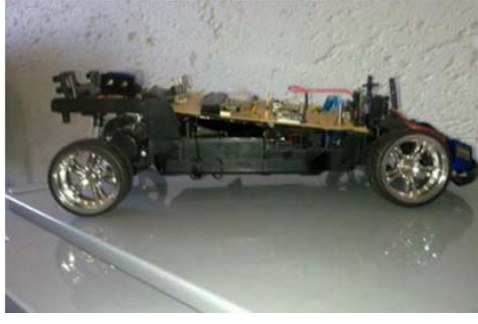
Figure 16. Mobile Router.